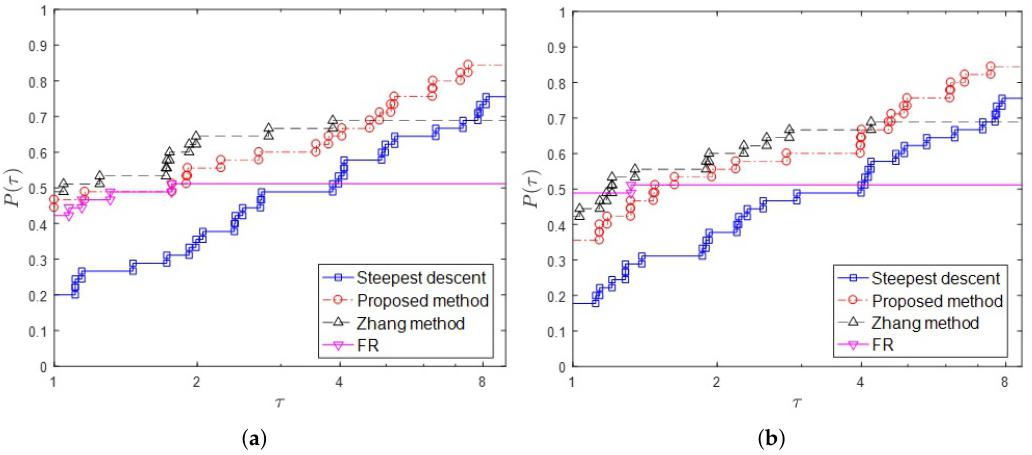
Figure 2. Performance profiles based on the number of function evaluations (Nf) ( a ) and the number of gradient evaluations (Ng) ( b ) for 45 functions in the Table